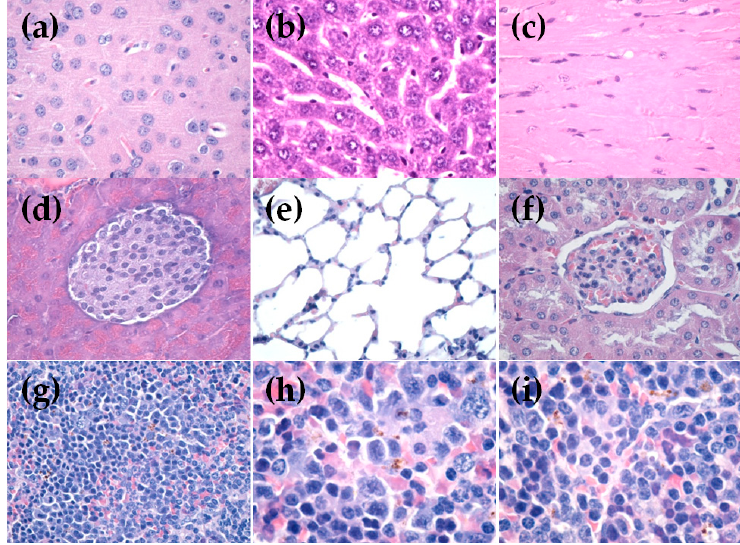
Figure 7. Cross-section of Fe 3 O 4 @PAT nanoparticles treated mouse brain ( a ), liver ( b ), myocardium ( c ), pancreas ( d ), lung ( e ), kidney ( f ), spleen ( g – i ). Collected samples after 14 days. Nanoparticles were observed only in the red pulp.Hematoxylin-Eosin staining (HE): ˆ 400 ( a – g ); ˆ 1000 ( h , i